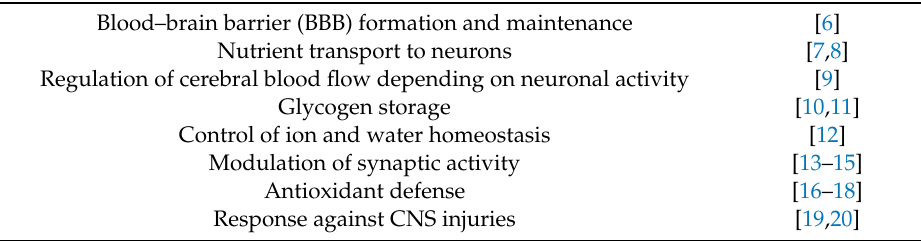
Table 1. Main functions of astrocytes in the